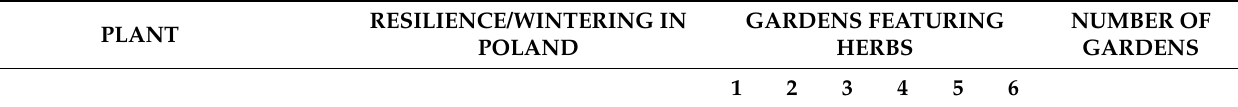
Table 2. Presence of aromatic herbs in the gardens under study. The plants typically used in these gardens, as well as more vulnerable plants originating from warmer areas of the world. V is a stamp which should be read as “yes”, in this case a confirmation that the plant is in the assigned